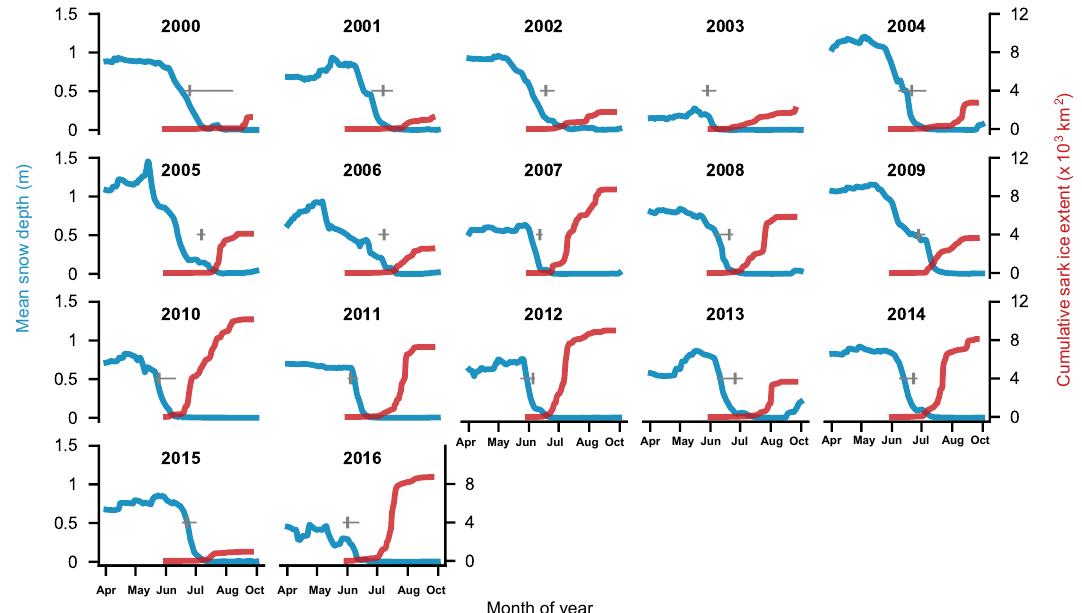
Figure 3. Average snow depth (blue) and cumulative dark ice extent, D E (red), in common area during April to August each from 2000 to 2016. Vertical bars (grey) denote e t B ; horizontal bars (grey) denote the interquartile range of the day of year of bare ice appearance.